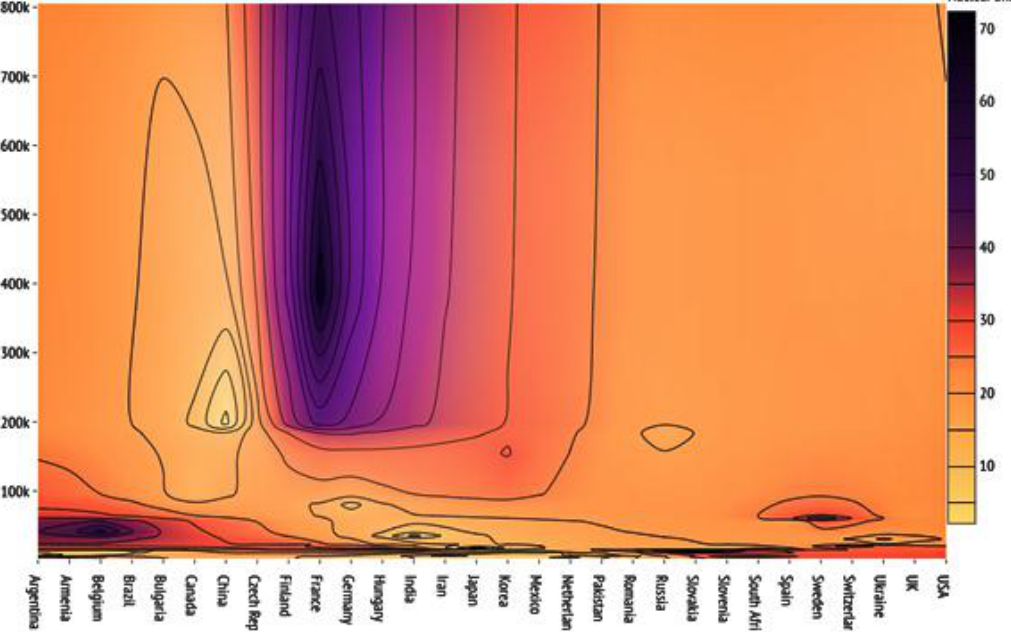
Figure 2. Heat map of worldwide nuclear power generation in nominal terms and as percentage of overall domestic power generation. Adapted from [12].